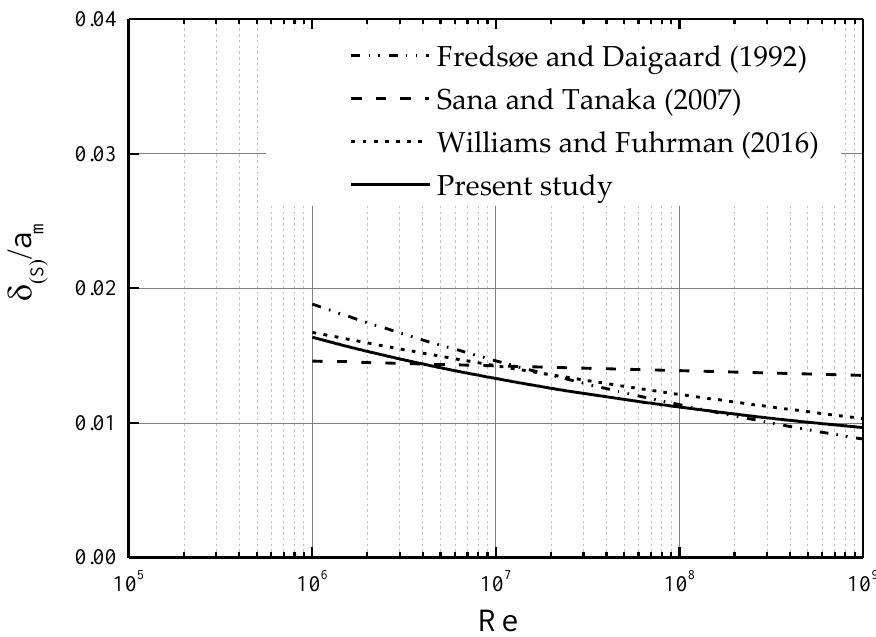
Figure 2. Comparison of calculation formulas for wave boundary layer thickness (smooth turbulent).